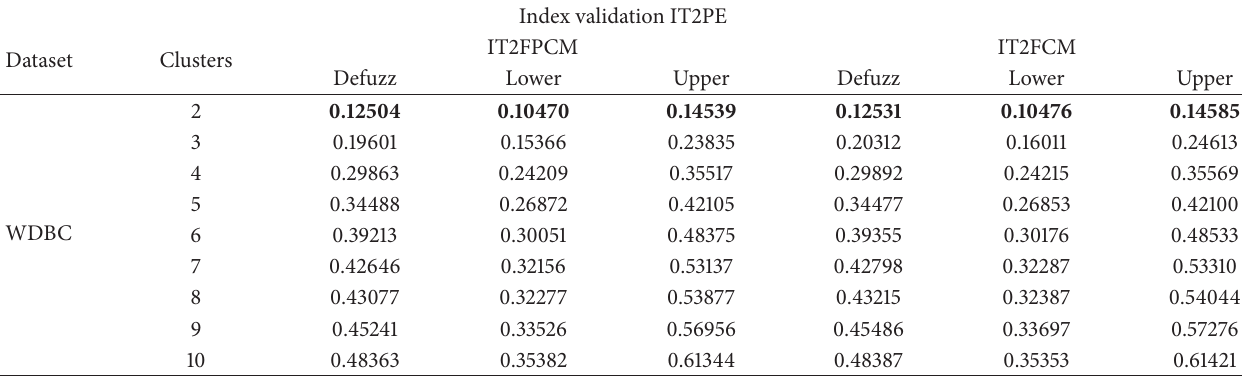
Table 2: Results of the IT2PE validation index for WDBC dataset clustering using IT2FPCM and IT2FCM algorithms with 𝑚 = [1.5, 2] and 𝜂 = [1.5, 2.5] as parameters.